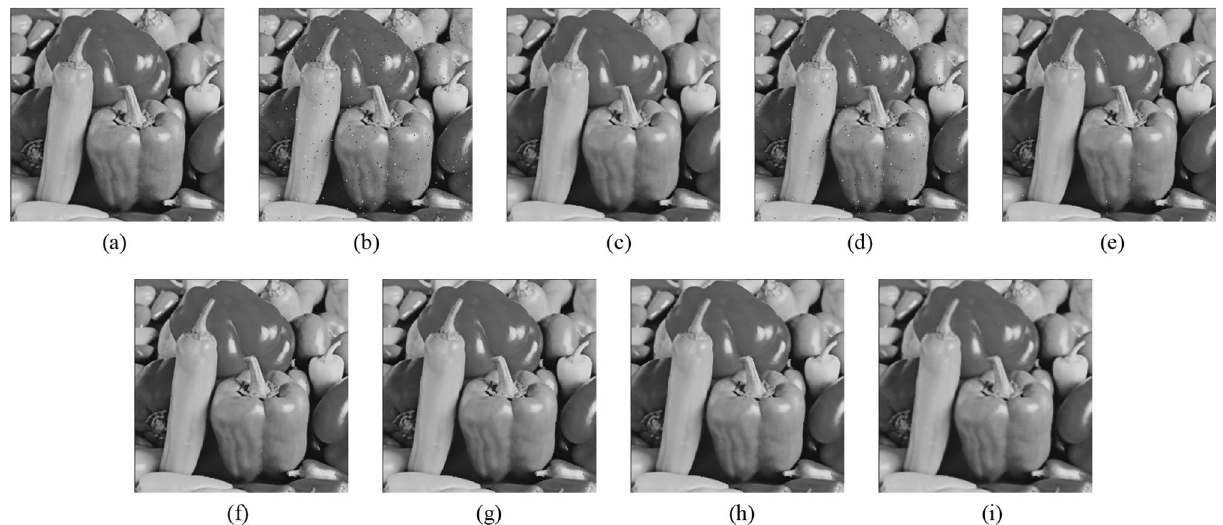
Figure 16. Comparison of denoising performance of each filter against the salt-and-pepper noise (“Pepper”). ( a ) Original image; ( b ) noise-added image; ( c ) filtered image using abwFMGFI; ( d ) filtered image using FMGFI (BW = 1 level); ( e ) filtered image using FMGFI (BW = 3 level); ( f ) filtered image using FMGFI (BW = 5 level); ( g ) filtered image using FMGFI (BW = 11 level); ( h ) filtered image using FMGFI (BW = 21 level); ( i ) filtered image using FMGFI (BW = 51 level).